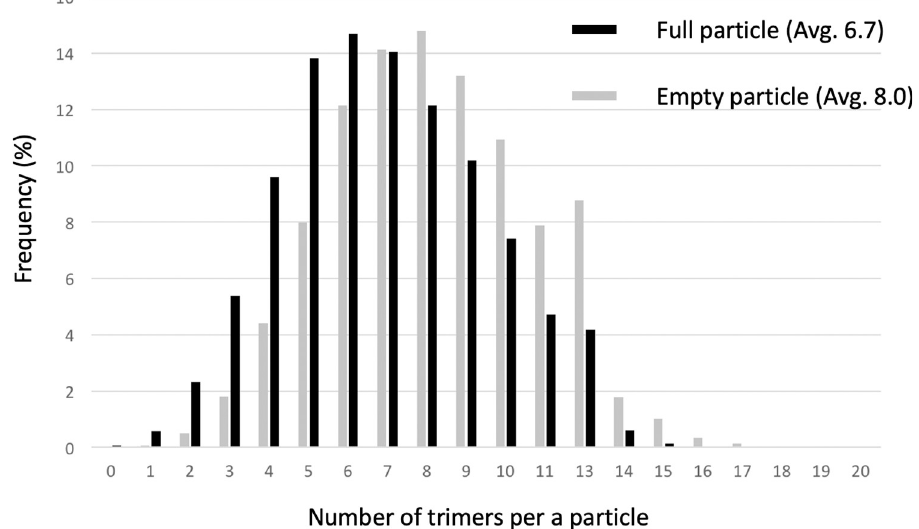
Fig 7. Number of CrP trimers on the particle and their distribution. After the 3D focused classification of CrP trimers, the number of CrP trimers bound to the particle is counted and the distribution is plotted. The averaged numbers of presented CrP trimers per particle are 6.7 and 8.0 for full and empty particles, respectively.